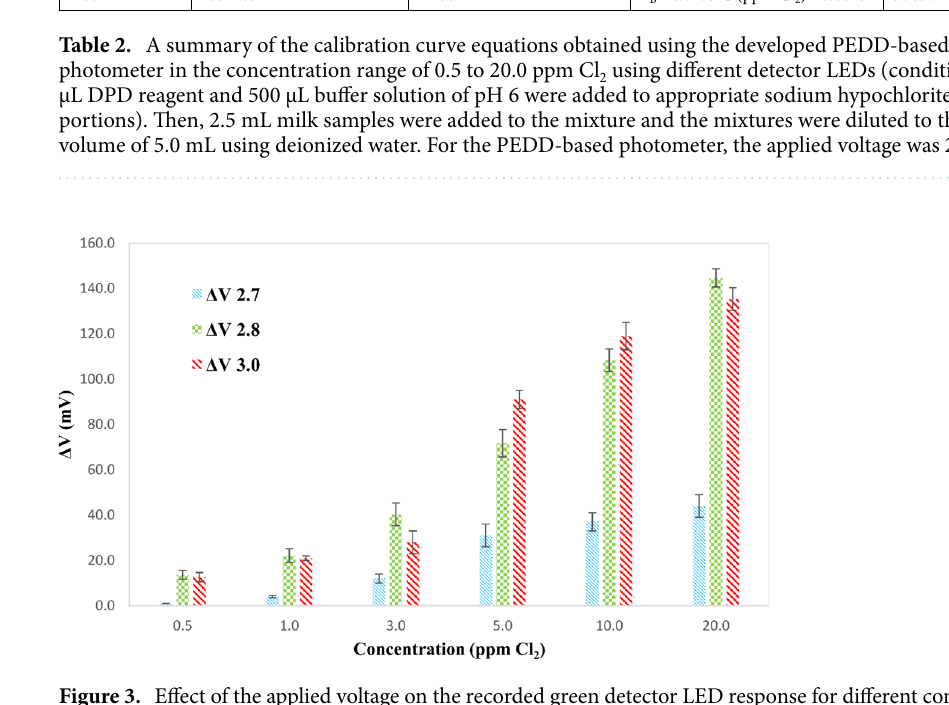
Figure 3. Effect of the applied voltage on the recorded green detector LED response for different concentrations of sodium hypochlorite in milk using the developed PEDD-based photometer (conditions: 500 µL buffer solution of pH 6, sodium hypochlorite solution, and 400 µL portions of the DPD reagent were mixed. Then, 2.5 mL milk samples were added to the solutions and the solutions were diluted to the total volume of 5.0 mL with deionized water to make theoretical 0.5 to 20.0 ppm Cl 2 initial